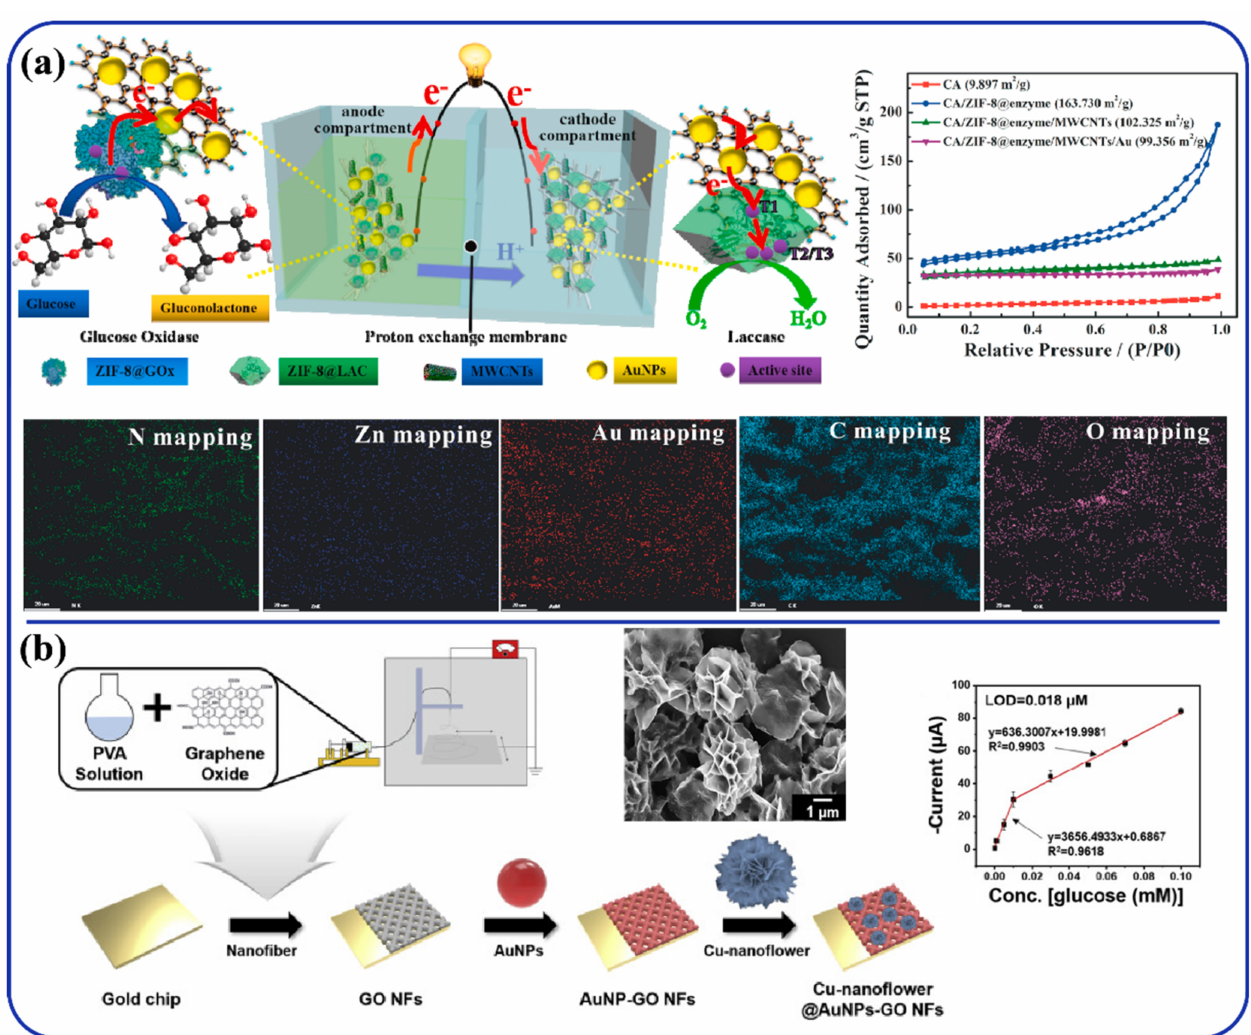
Figure 4. ( a ) Schematic of the self-powered glucose biosensor; SEM-EDS elemental mapping images of CA/ZIF- 8@enzyme/MWCNTs/Au electrode; BET analysis of as-prepared samples [105]. ( b ) Schematic illustration for the fab- rication of Cu-nanoflower/AuNPs-GO NFs-based electrochemical glucose biosensor and FE-SEM image formation of Cu-nanoflowers